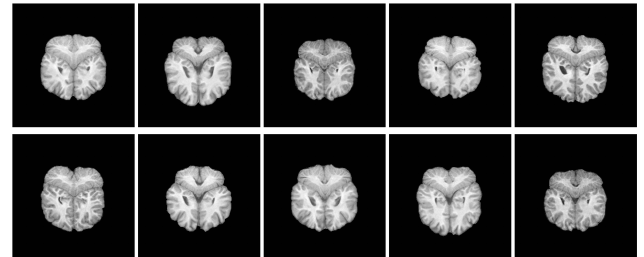
Figure 11. Original images.